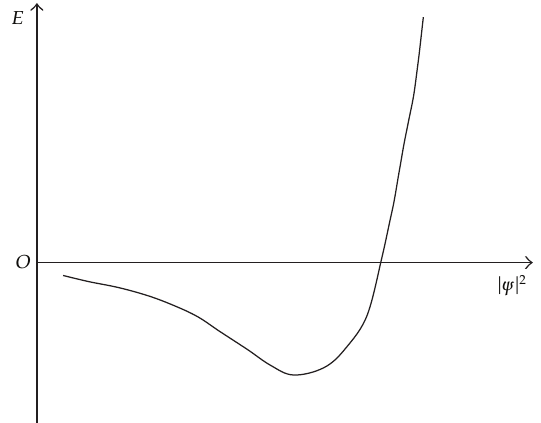
Figure 2: The atom-atom interaction potential energy as a function of the density of